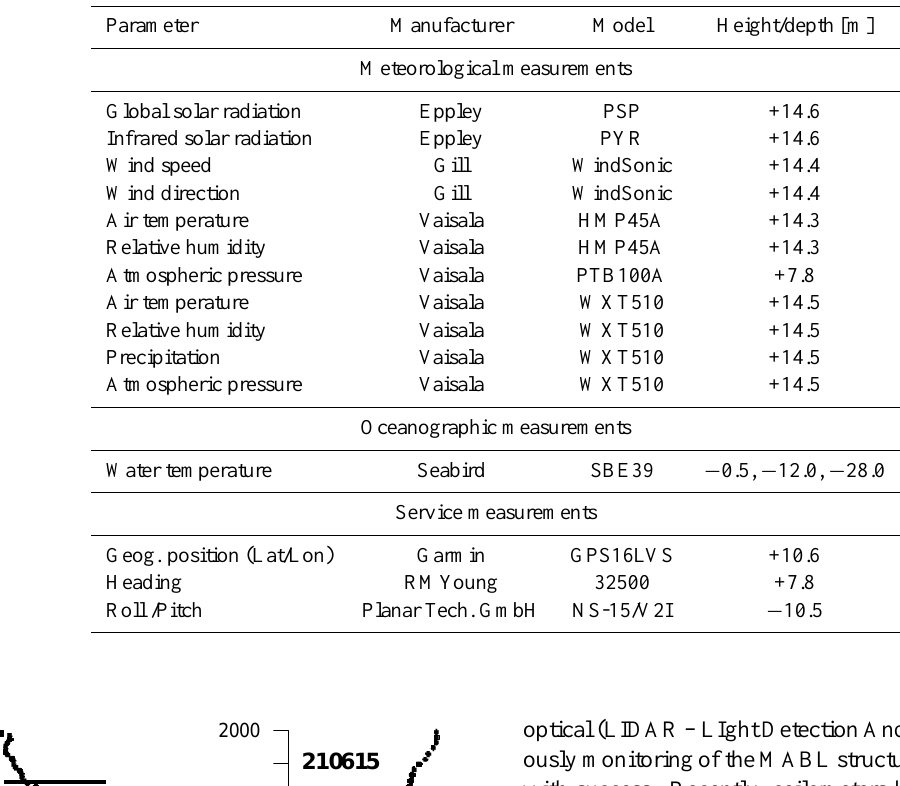
Table 1. Equipment on the ODAS Italia 1 buoy.